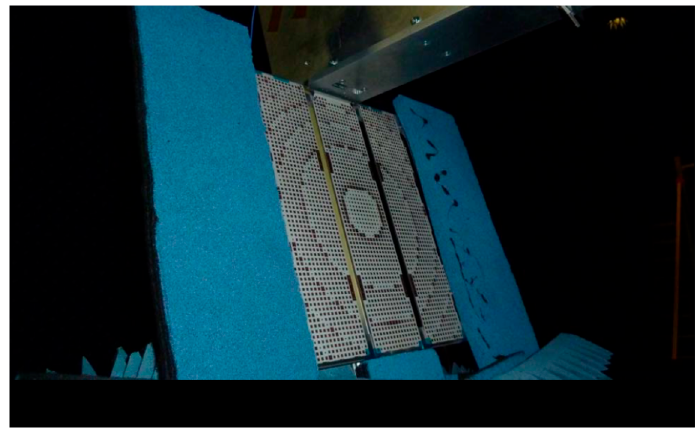
Figure 11. ISARA antenna [14]. The antenna is mounted on a mock-up structure of the CubeSat, in the deployed configuration.